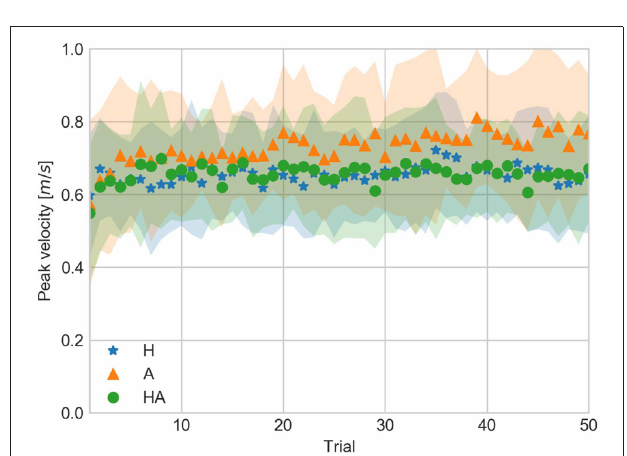
FIGURE 10 | Peak velocity against trial number averaged over all subjects for the haptic (H), acoustic (A), and haptic-acoustic (HA) conditions. The contour represents the standard deviation.